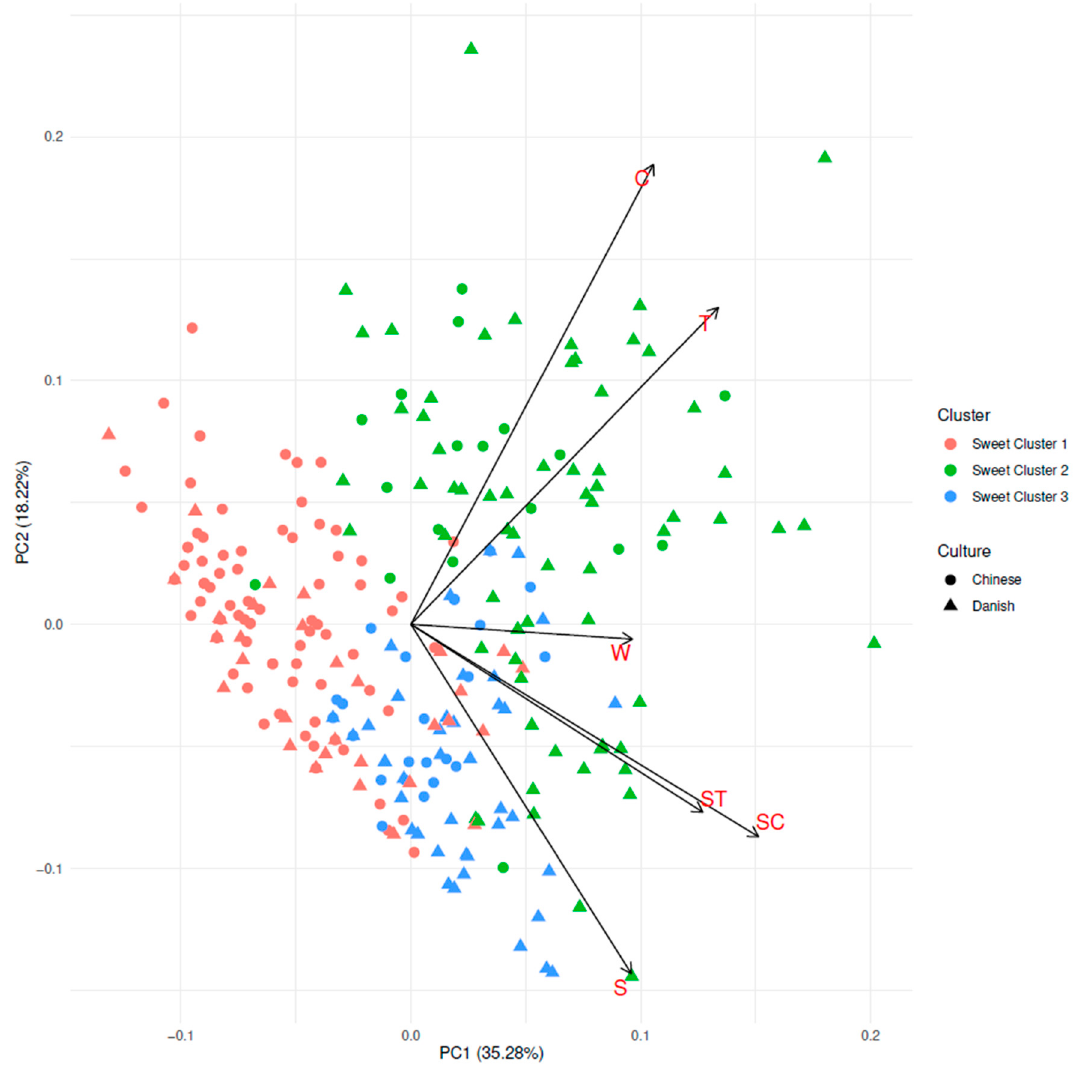
Figure 4. PCA biplot showing consumers sweetness ratings. Both their relation to clusters and culture are visualized. Samples are Water (W), Citric acid (C), Tartaric acid (T), Sucrose (S), Sucrose and Citric acid (SC), and Sucrose and Tartaric acid (ST).